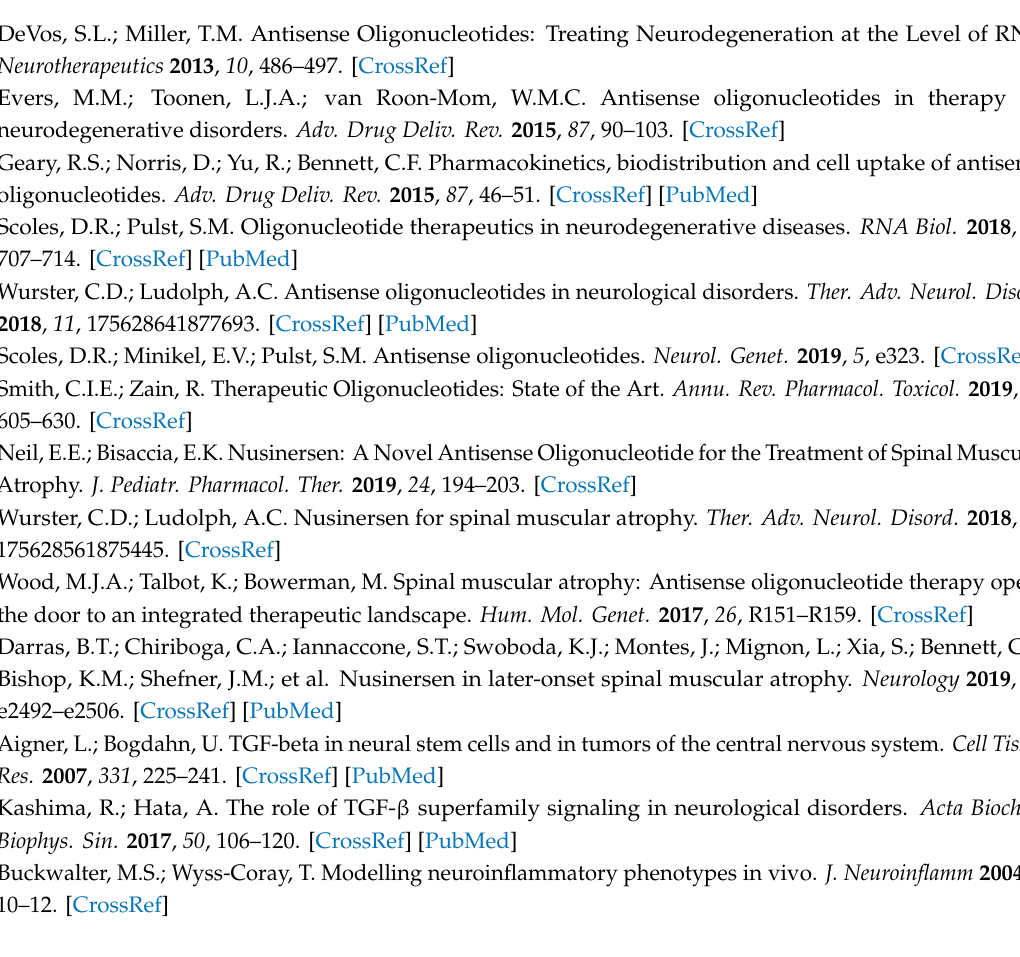
s1, Figure S1: Transfection experiments at low dose (5nM), Figure S2: Original Western Blot, Figure S3: Immunocytochemical stainings against TGFBR2, pSmad2, Figure S4: Integrity of NVP-13 at -20 ◦ C up to 12 months, Figure S5: Integrity of NVP-13 at 5 ◦ C tested for 1 week, Figure S6: Integrity of NVP-13 at 37 ◦ C tested for up to 1 month, Table S1: BLASTn1 query results for TGFBR2 sequences, Table S2: NVP-13 ASO sequence